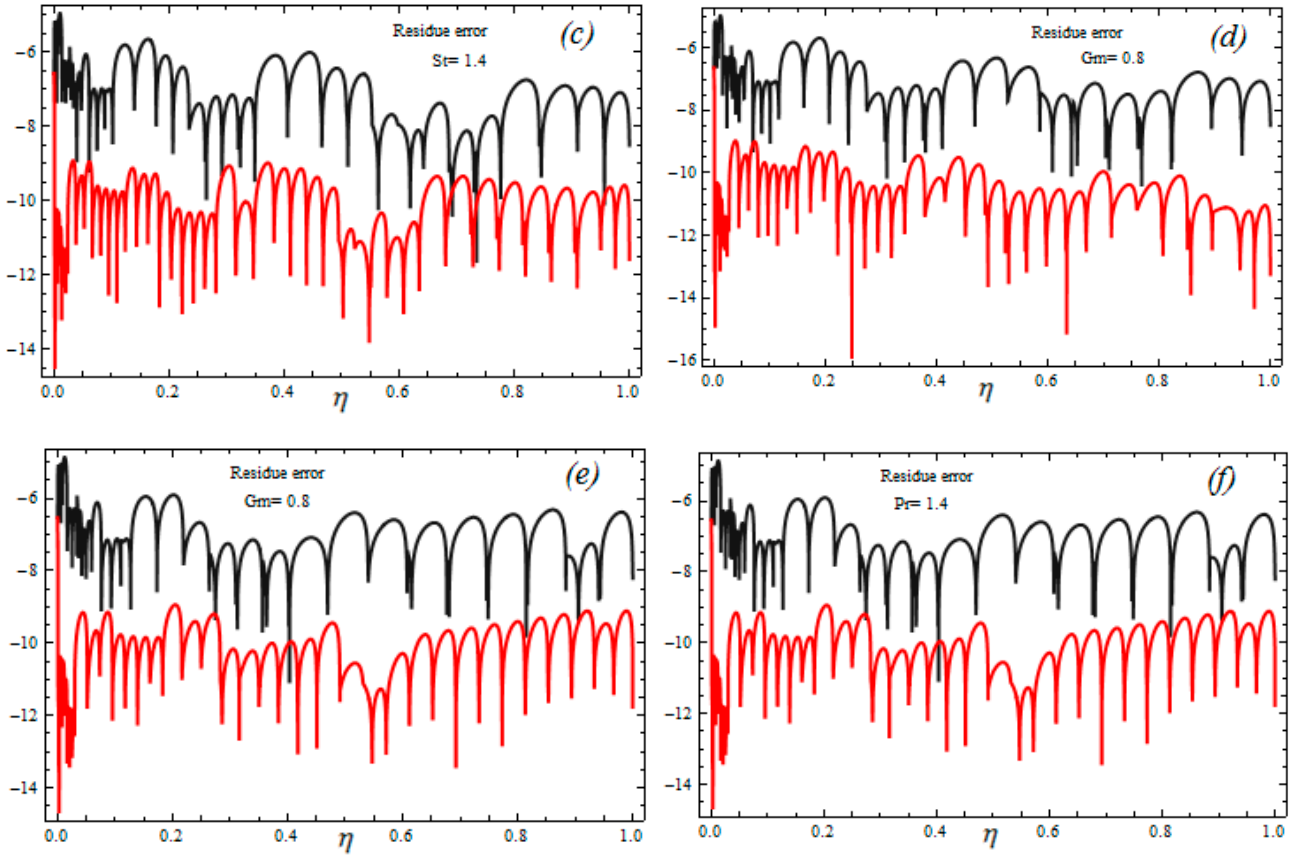
Figure 4. ( a – f ). Residue error analysis for different parameters ( a ) β = 0.2, ( b ) M = 0.5, ( c ) G r = 0.2, ( d ) St = 1.4, ( e ) G m = 0.2, and ( f ) Pr =